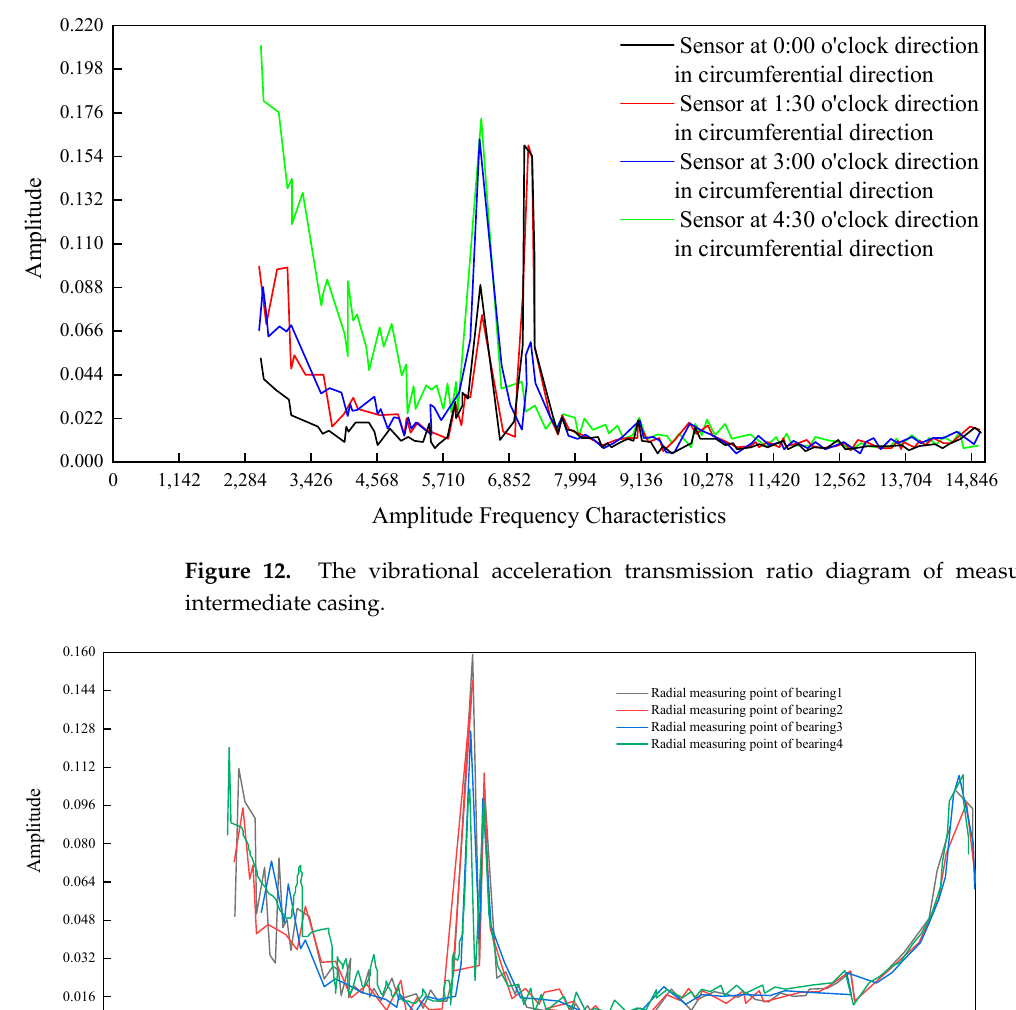
Amplitude Frequency Characteristics Figure 13. Influence of the changed bolt status for the intermediate casing flange on the vibration characteristics.